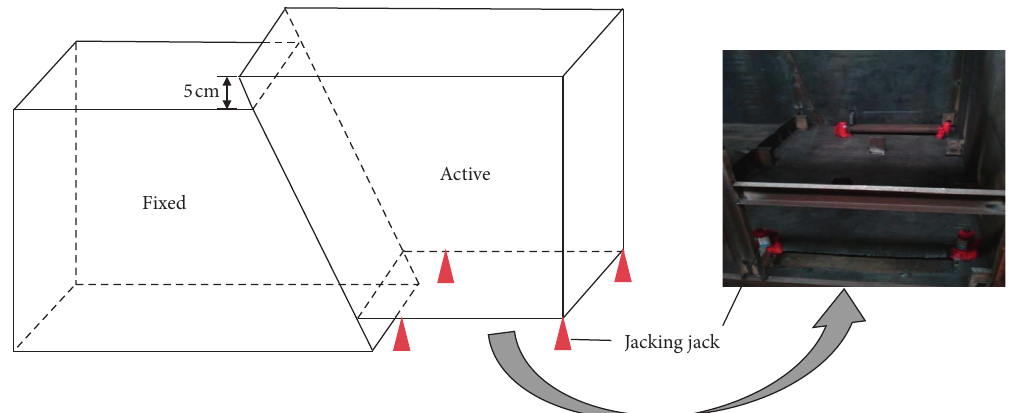
Figure 7: Test device and schematic